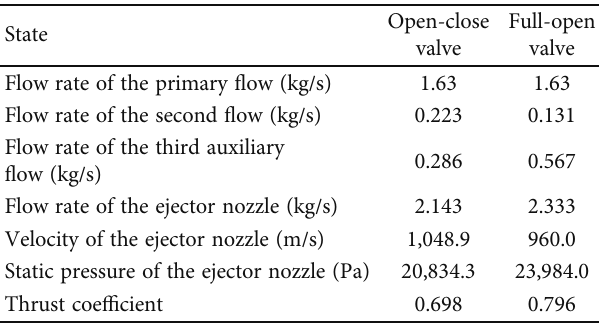
Figure 15: Vortex structure of monitoring surface e (outlet of the tail nozzle). Table 4: Thrust performance parameters of the ejector nozzle under two di ff erent working